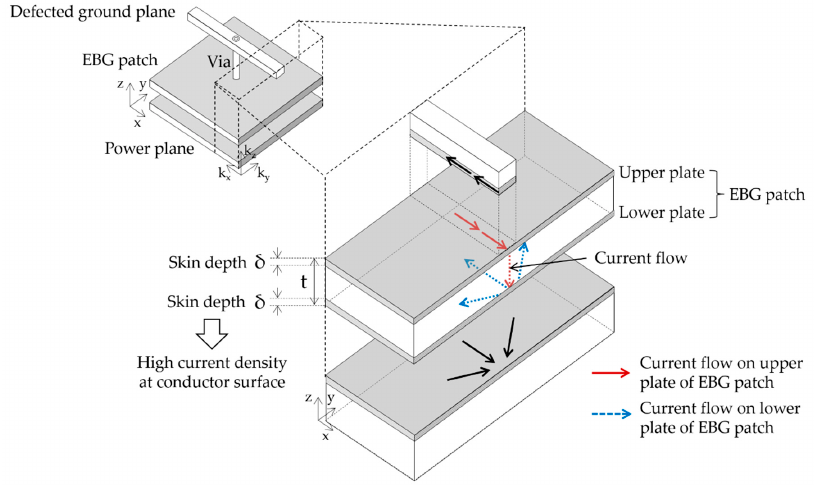
Figure 4. Skin effect and current flow on the DGS–EBG unit cell. Figure 4. Skin e ff ect and current flow on the DGS–EBG unit cell.